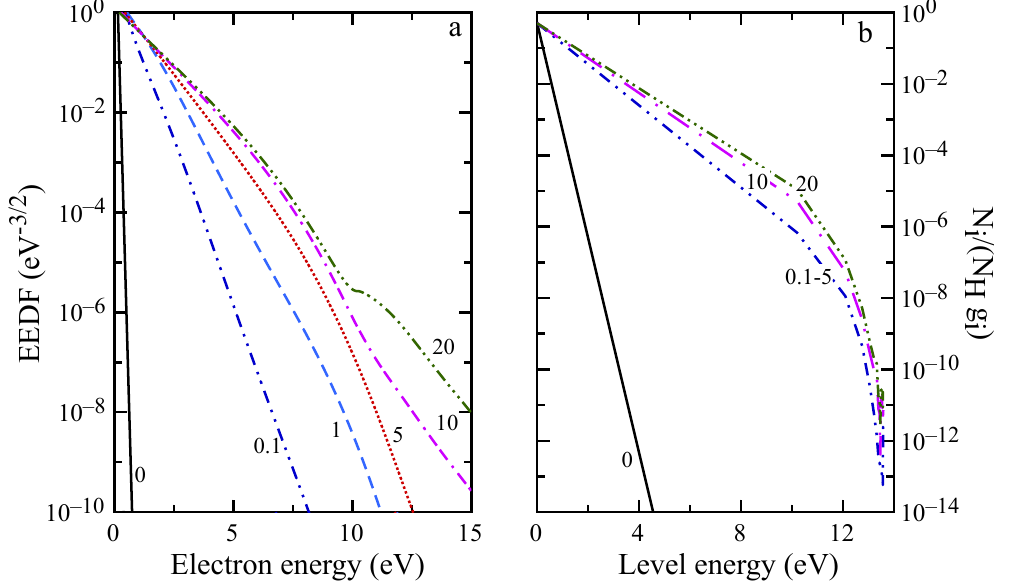
Figure 8. EEDF ( a ) and hydrogen atom internal distribution ( b ) at different positions in the ionization region for a supersonic flow at Mach 20. The curve labels represent the distances (in mm) from the shock